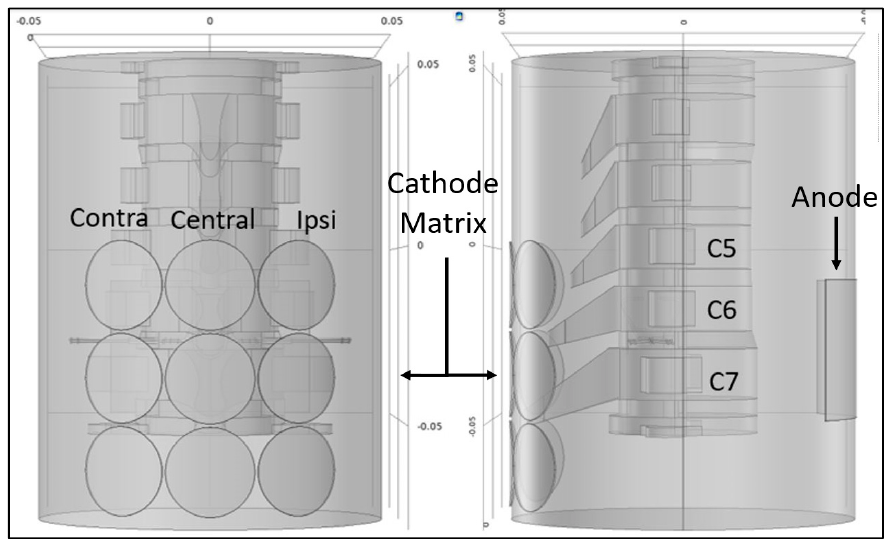
Figure 1. Graphical model of electrode array in the coronal (left) and sagittal (right) planes. A 3 × 3 cathode matrix was placed dorsally at the approximate levels of C5/6, C7 and C8 spinal nerves in contralateral, central and ipsilateral arrangements. A rectangular 5 × 10 cm anode was placed ventrally, with the caudal border of the electrode in line with the C7 spinous process.